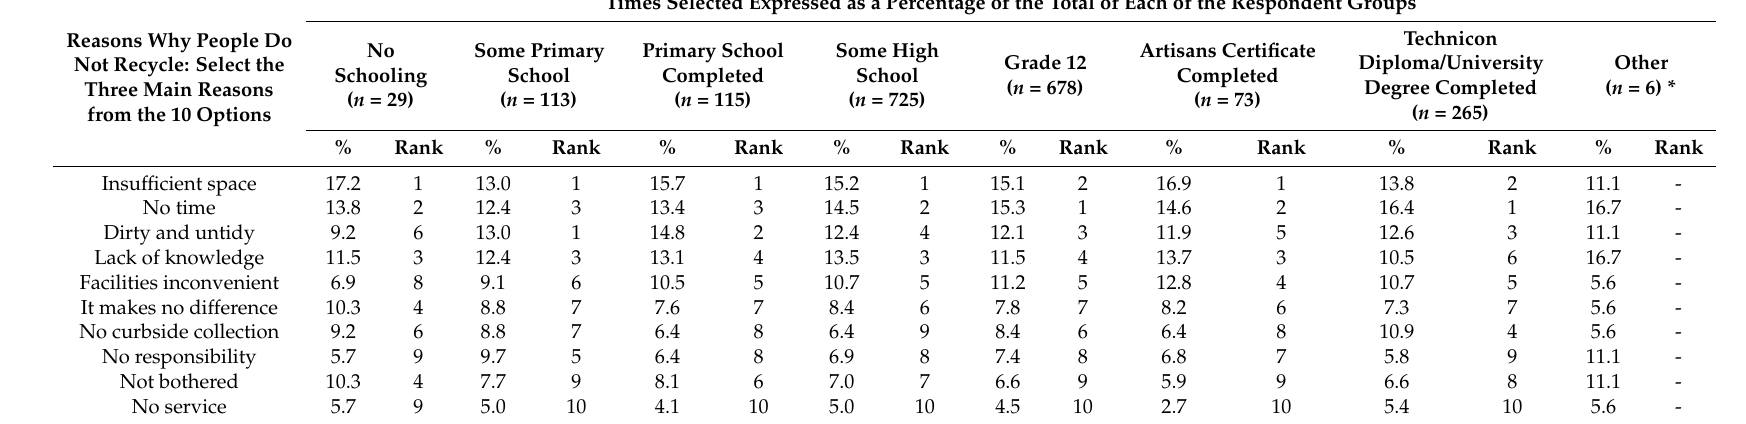
Table A6. Reasons why people do not recycle as enumerated per education of the respondent ( n =